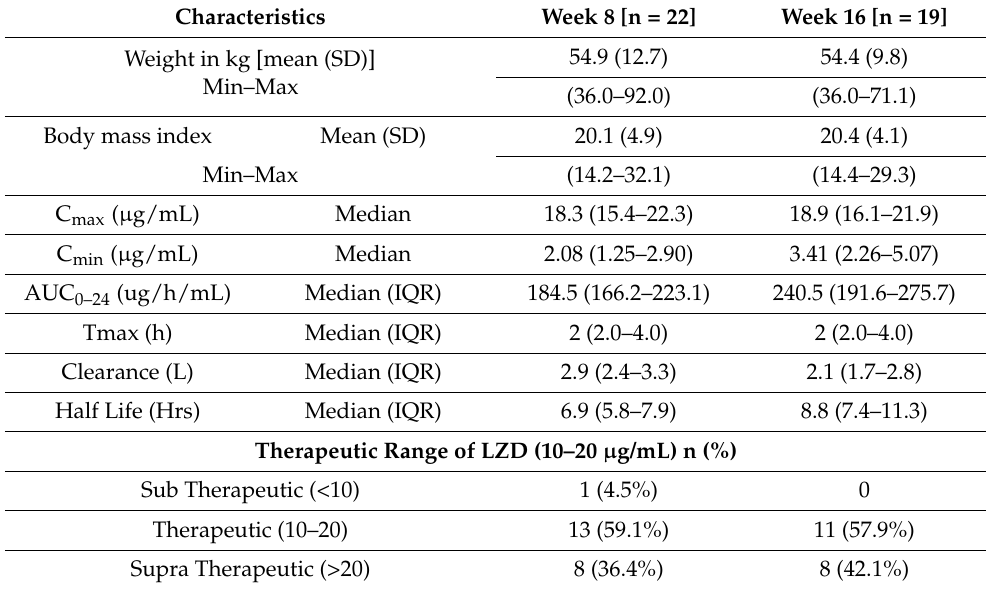
Table 1. Demographic and pharmacokinetic parameters of participants who underwent intense pharmacokinetic testing for tablet